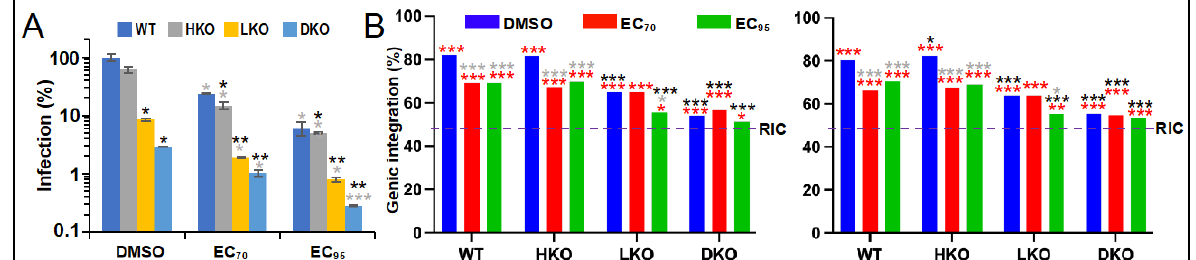
Figure 2. Consequences of ALLINI action in LEDGF/p75 and HDGFL2 knockout cells. ( A ) HIV-Luc infectivities in the indicated cell type in the presence or absence of BI-D. Results (average ± standard deviation from two independent experiments; within each experiment, luciferase values were de- termined for technical triplicate samples) were percent normalized to DMSO-treated WT cells. ( B ) Percent genic integration targeting for the infections shown in A; see Table 1 for plotted values (the graph on the left is replicate 1 data) and Table S2 for pairwise statistical comparisons. *, p < 0.05; **, p < 0.001; ***, p < 0.0001 (gray asterisks, versus matched DMSO control; black asterisks, versus matched WT cell condition; red asterisks, versus random integration control [RIC; dotted line]). Table 1. Integration sites in BI-D-treated HEK239T cells 1 .